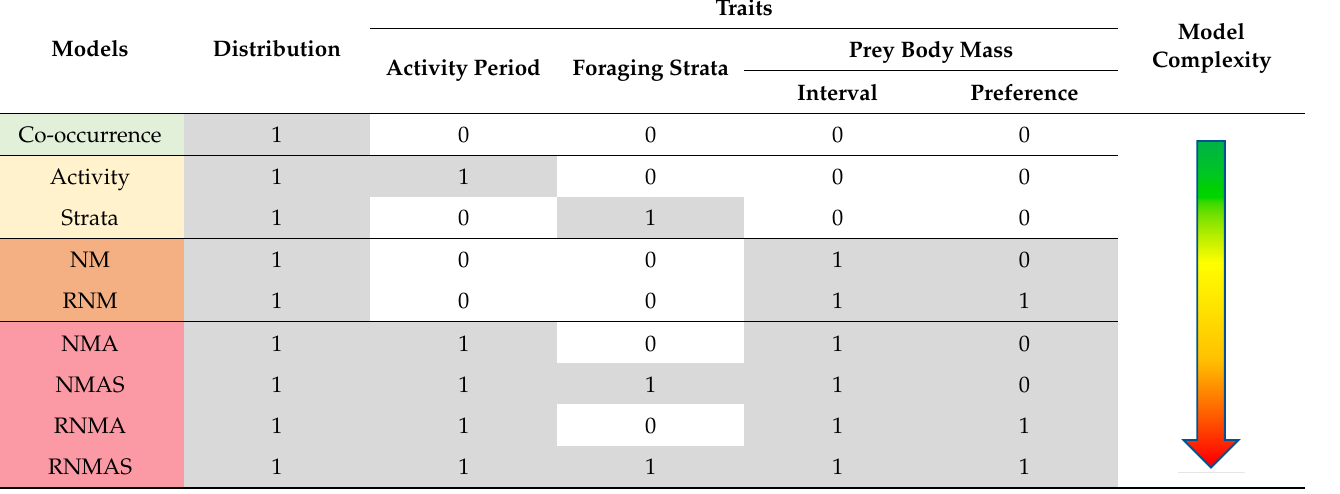
Table 1. Species’ trait combinations used in the interaction models for inferring predator–prey interaction properties. Values of 1 imply the consideration of that trait in the corresponding model (row), 0 values otherwise. NM = Niche Model, RNM = Restricted Niche Model, NMA = Niche Model with Activity, NMAS = Niche Model with Activity and Strata, RNMA = Restricted Niche Model with Activity, and RNMAS = Restricted Niche Model with Activity and Strata (see text and Supplementary Materials File S1–S3 for detailed descriptions). Colors indicate model complexity following the scale depicted by the arrow at the right.